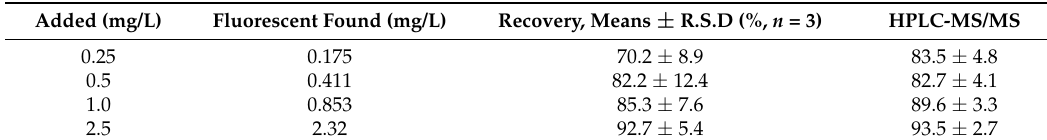
Table 1. Results for analysis of melamine in milk samples.